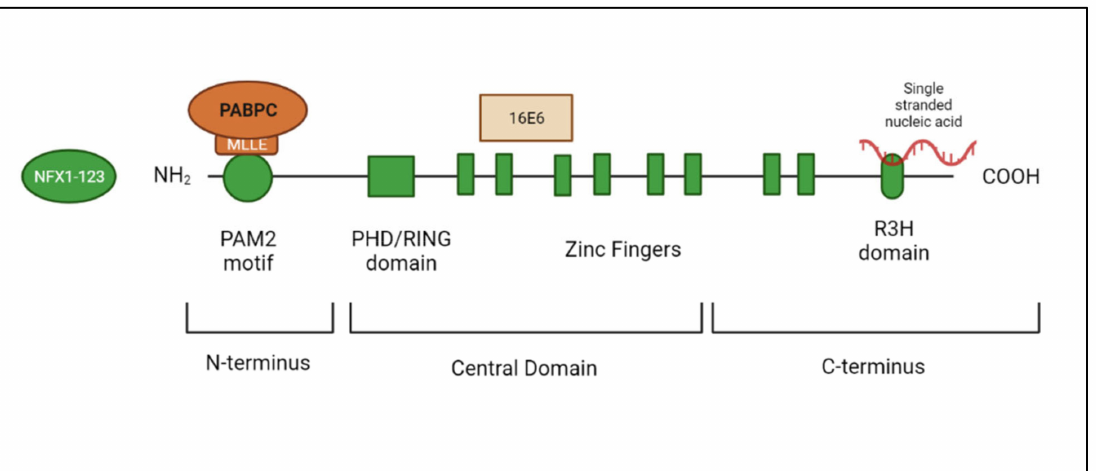
Figure 3. Binding partners of NFX1-123 . The MLLE domain of PABPCs binds to NFX1-123 at its N-terminal PAM2 motif. HPV 16E6 binds within the central domain. The R3H domain of the C-terminus has putative single-stranded nucleic acid binding capabilities. Figure created with